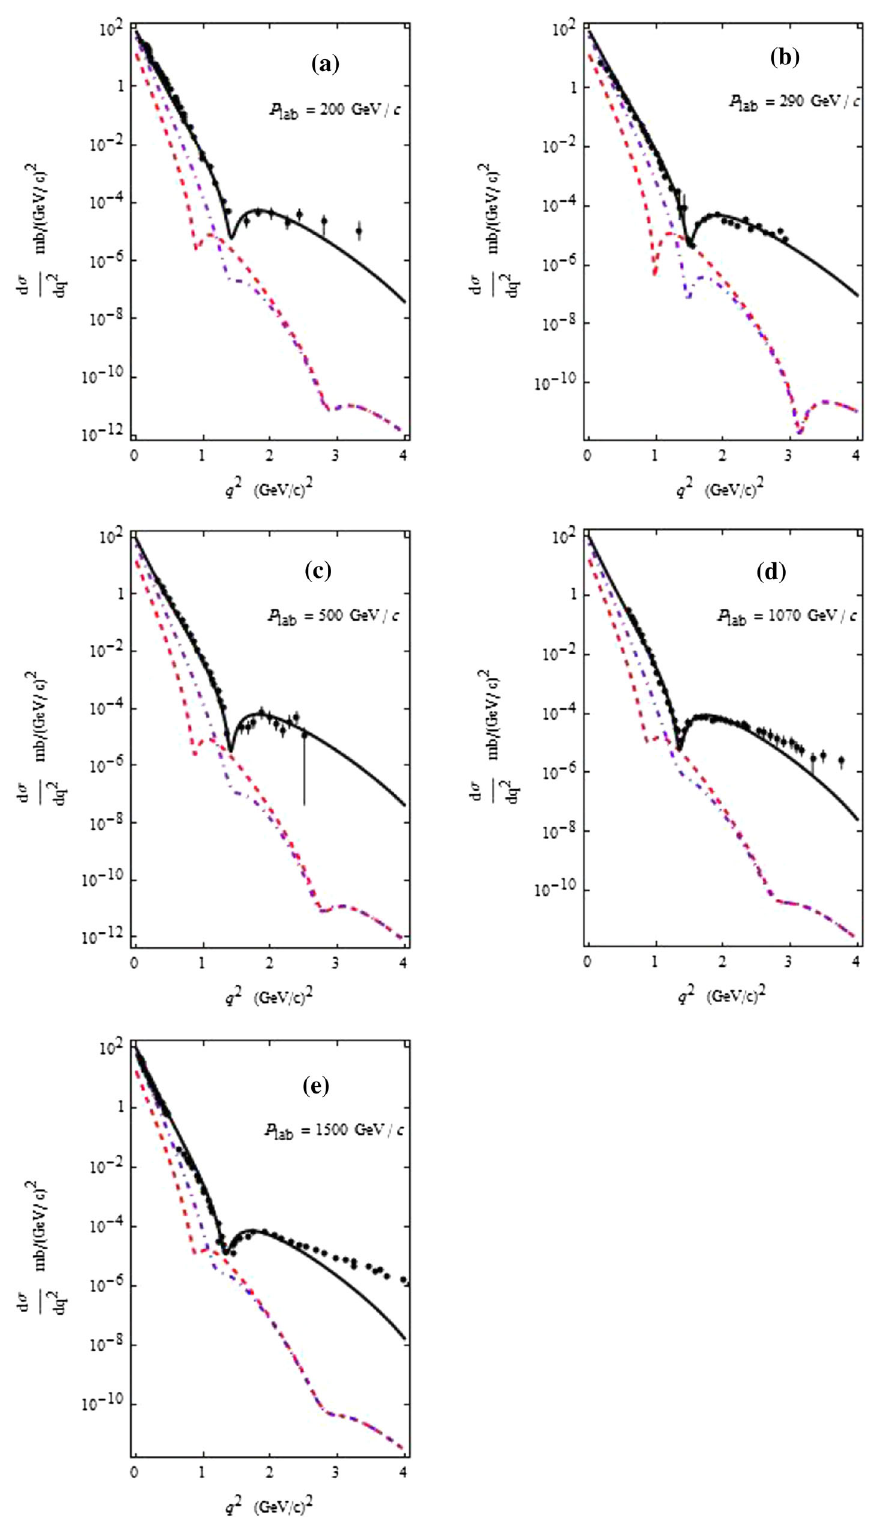
Fig. 1 The p–p elastic scattering differential cross section. The results for 200, 290, 500, 1070 and 1500 GeV/c are given in figures ( a – e ), respectively. The dashed, dot- dashed and solid curves represent the results of (two-quark force) only, (two-quark force + pion cloud effect), and (two-+three-quark force+ pion-cloud effect), respectively. The experimental data are taken from